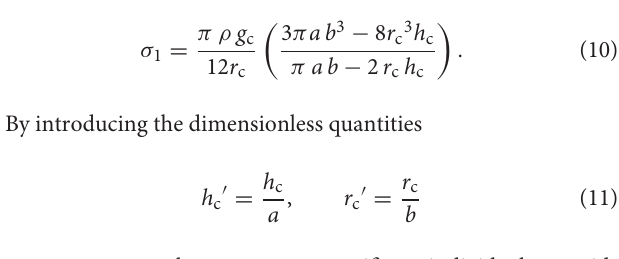
FIGURE 4 | Model 1 material stress for different dimensions of the space station (dimensionless radius r c and height h c ). The blue contour lines give the ratio σ 1 ρ g ρ given in gcm − 3 , g c measured in units of g E , and b measured in meters, respectively. The dotted red lines give contours of the ratio S ab obtained via (14), the upper x -axis gives the scaled rotation